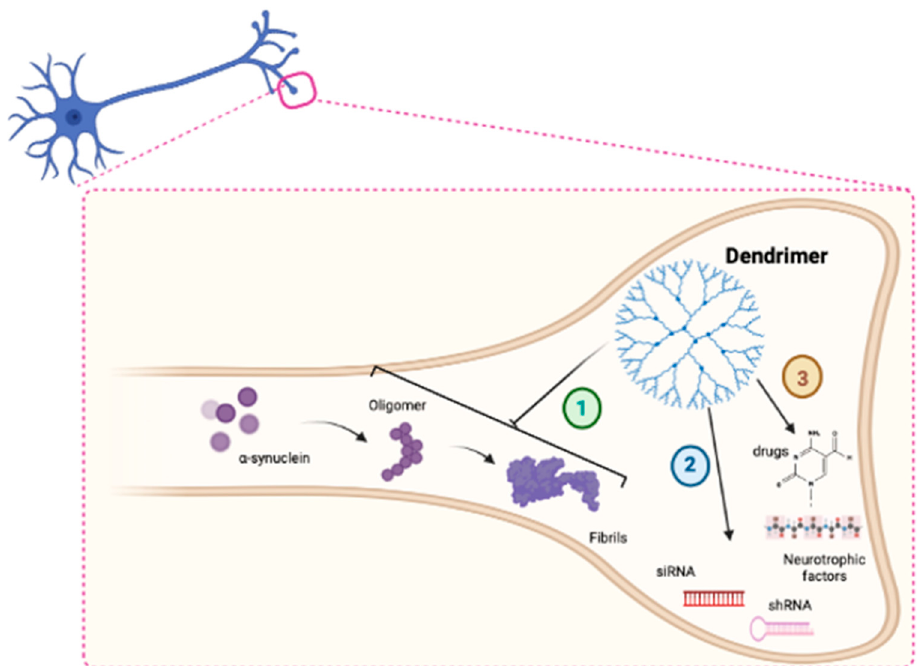
Figure 3. Schematic representation of the main mechanism of action of DDs in PD (1). DDs could block α -syn fibrillation (2). DDs could act as delivery systems for siRNA molecules (3) and drugs in neurons.